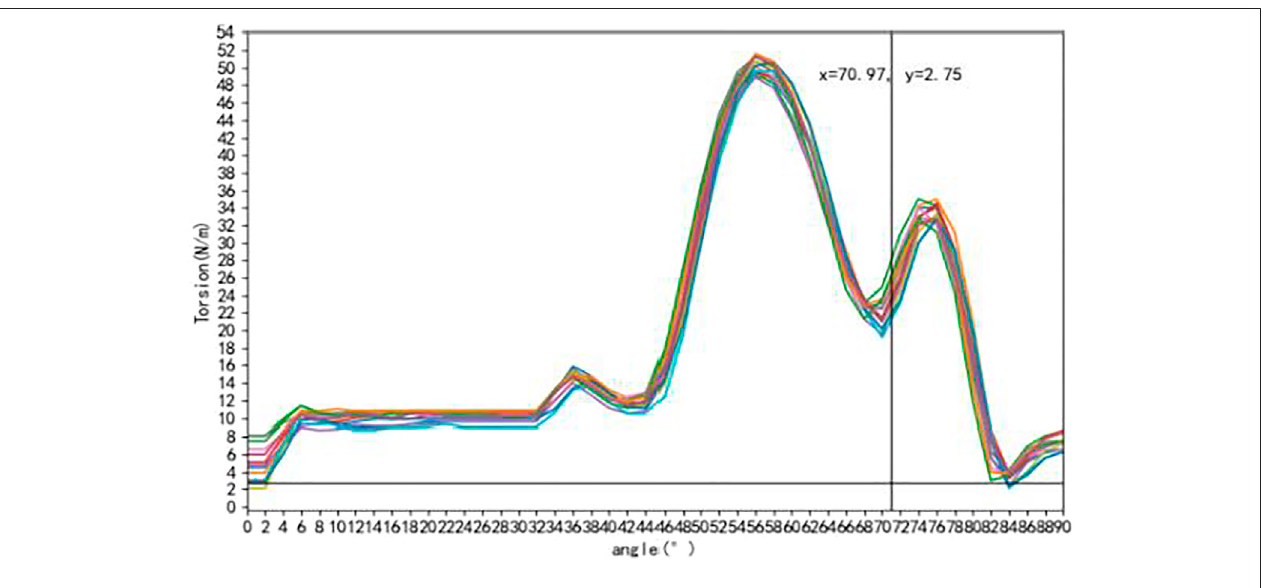
FIGURE 9 | Torque-angle motion curve of 100 repetitions (closing).